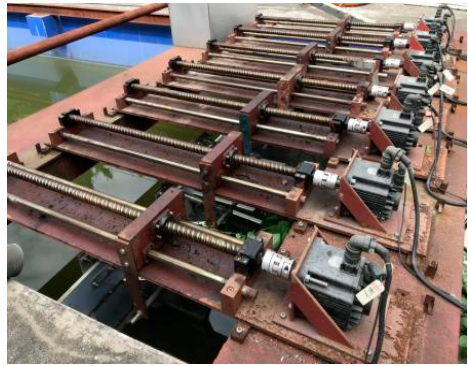
Figure 7. Wave-making system.